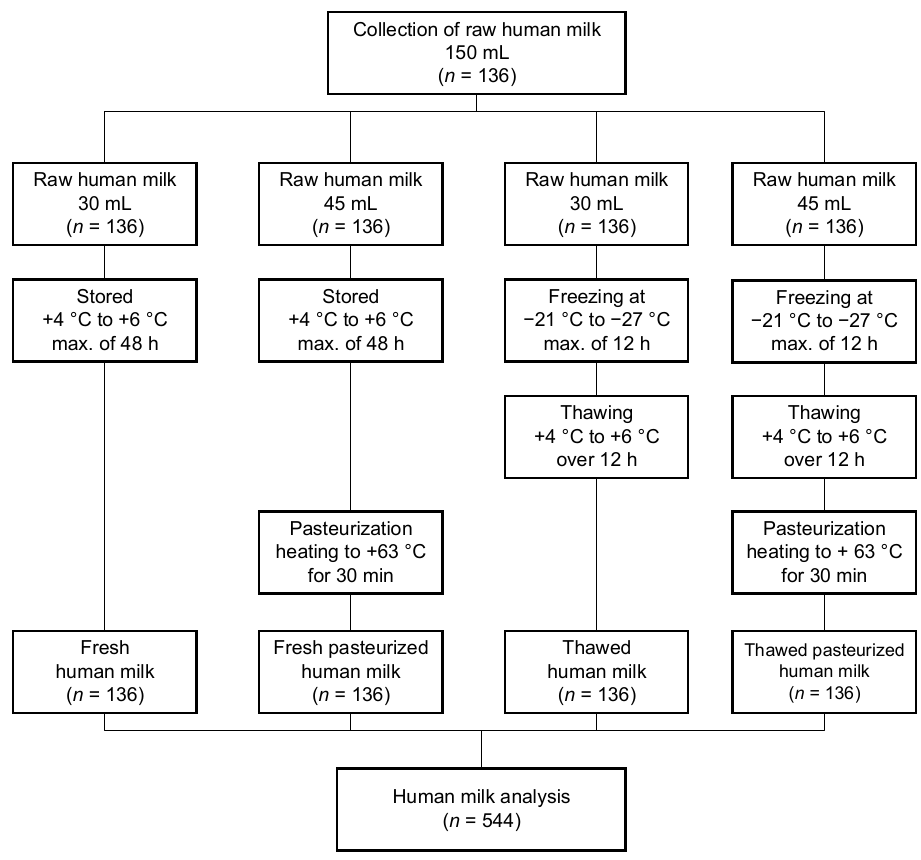
Figure 1. Description of study design. max.,